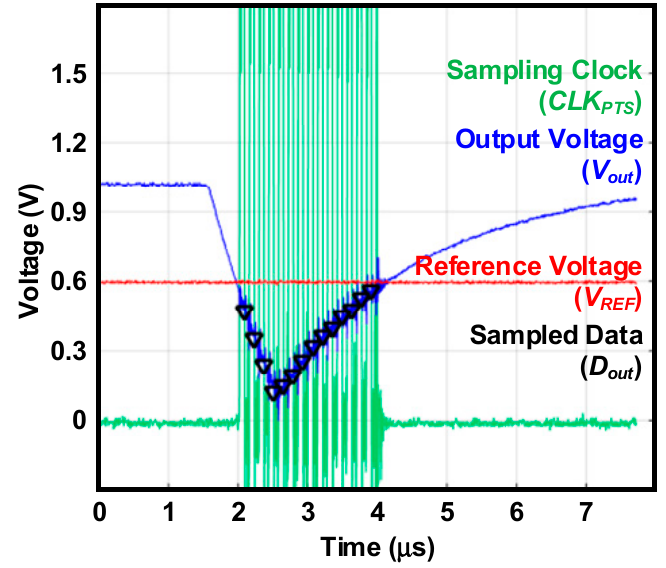
Figure 7. Measured output waveforms with the proposed sampling scheme.